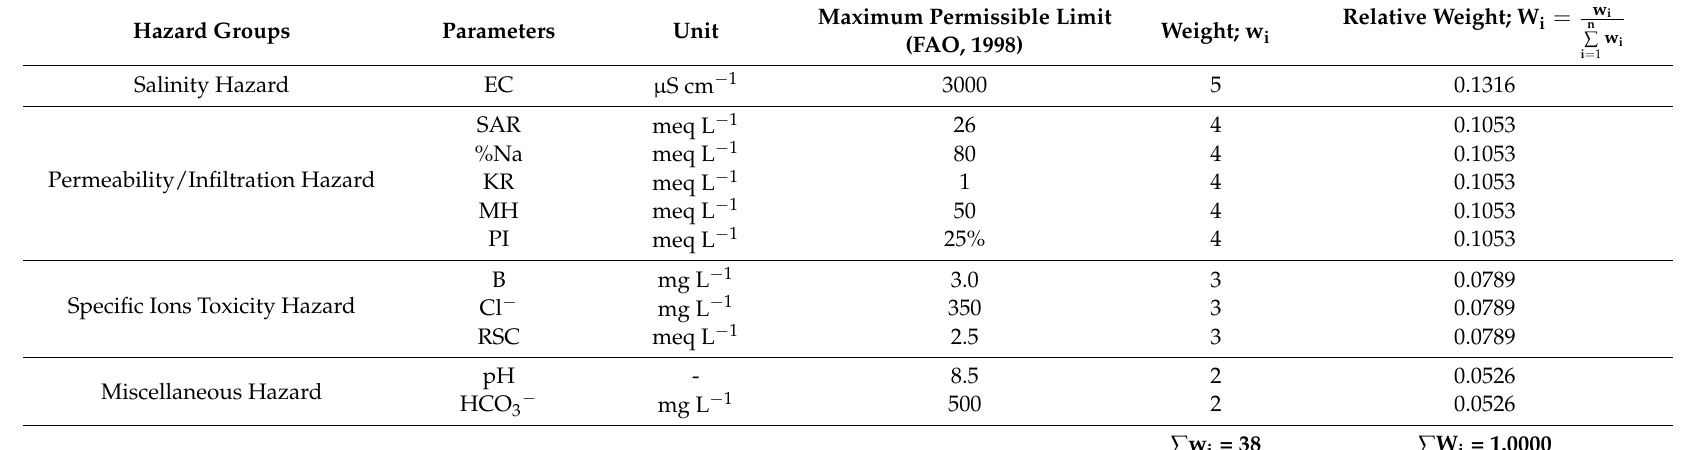
Table 2. Irrigation water standards, weight coefficient and relative weight of the hydrochemical parameters for